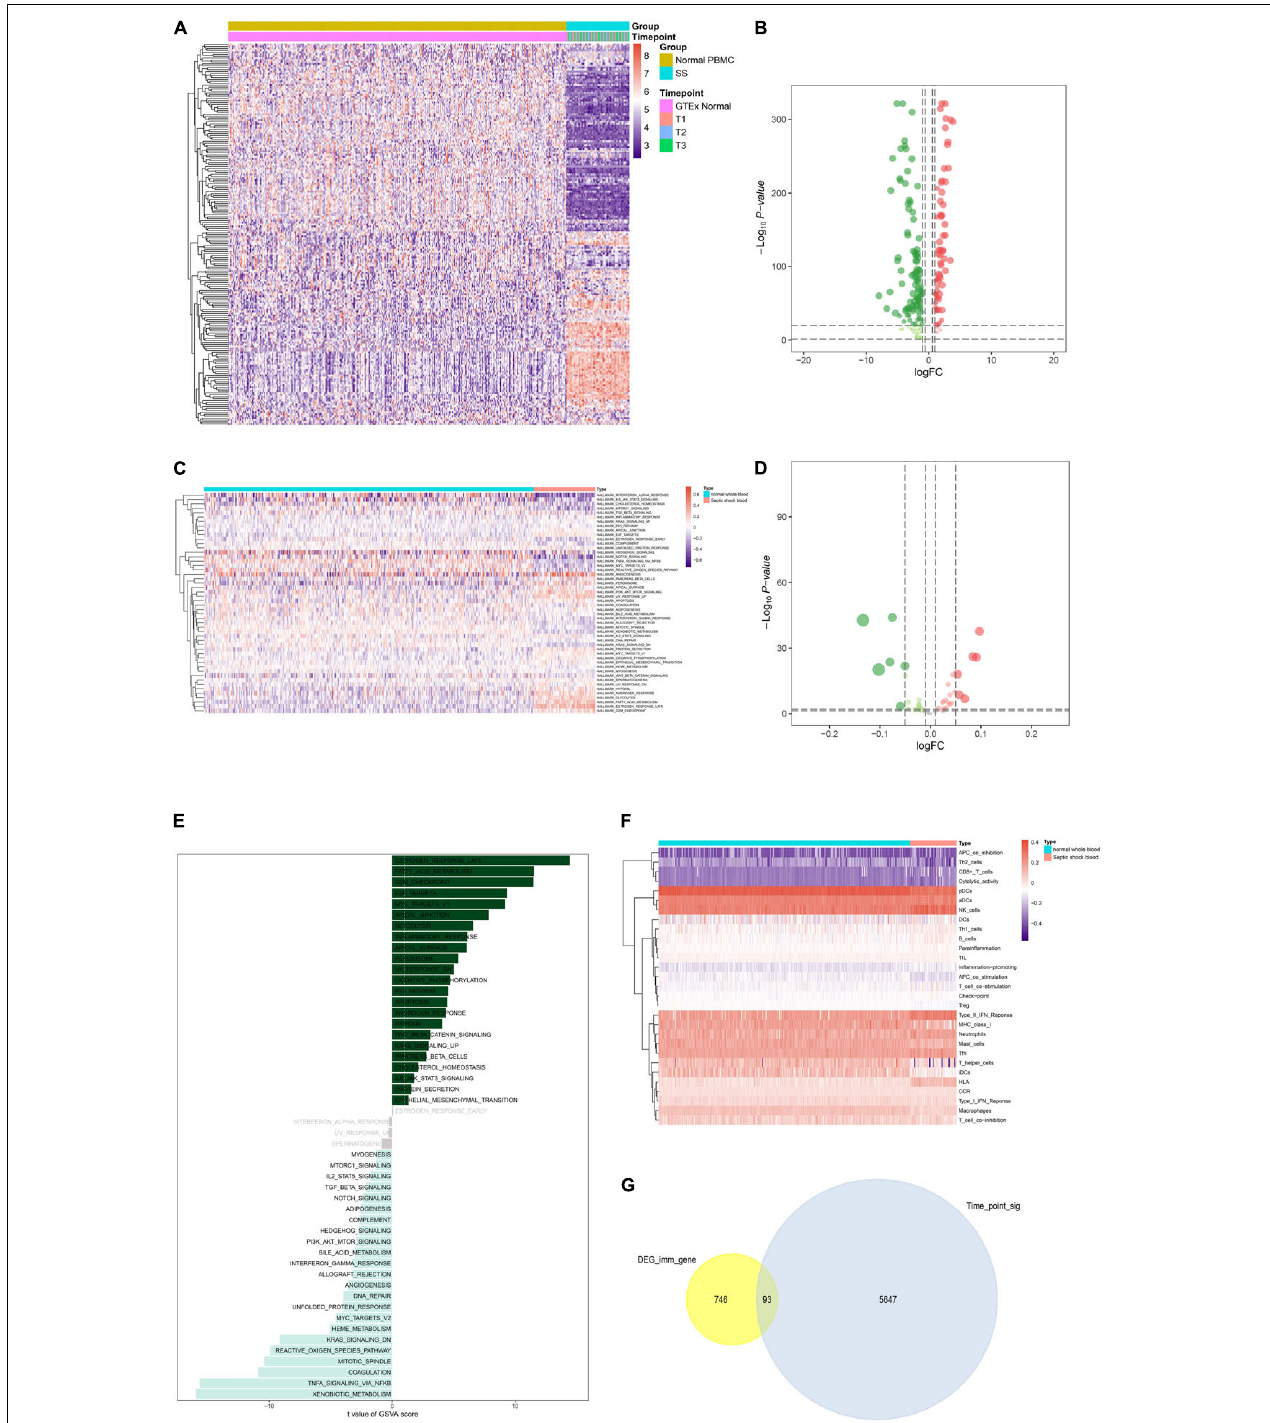
FIGURE 4 | Identification of upstream TFs and the downstream pathways/immune cells/immune gene sets of SSSIRGs. (A) Heat map showing the expression level of differentially expressed TFs. (B) Volcano plot showing the differential expression patterns of TFs, where green dots refer to down-regulated genes while red dots refer to up-regulated genes. (C) Heat map showing the expression level of hallmark signaling pathways in normal whole blood and septic shock blood by Gene Set Variation Analysis (GSVA). (D) Volcano plot showing the differential expression patterns of hallmark signaling pathways, where green dots refer to down-regulated pathways while red dots refer to up-regulated pathways. (E) The bar plot revealing the t -value of GSVA score of hallmark pathways. (F) Heat map showing the expression level of 29 immune gene sets via single-sample Gene-Set Enrichment Analysis (ssGSEA). (G) Venn plot showing that only 93 of 839 SSSIRGs with differentially expressed patterns were significantly associated with blood collection time points